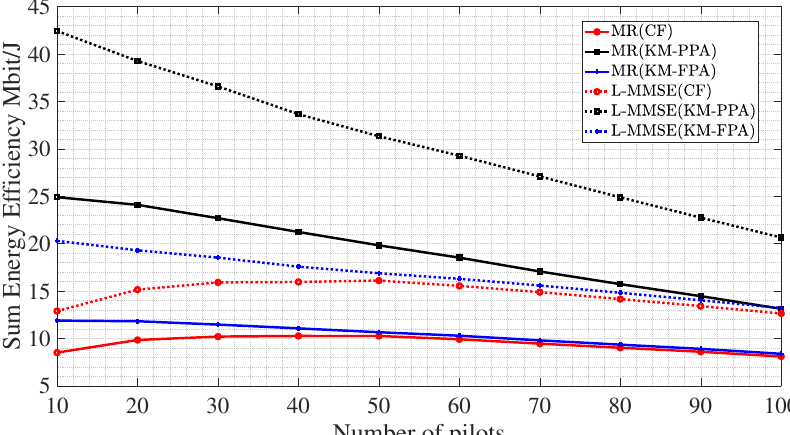
Figure 3. The sum energy efficiency versus the number of pilots, access point (AP) with single